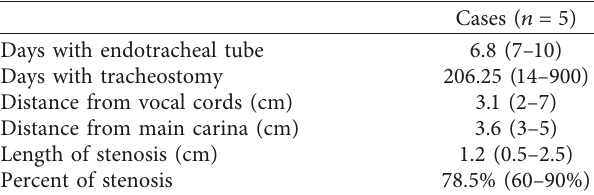
Figure 12: Site of stenosis. Table 3: Characteristics of